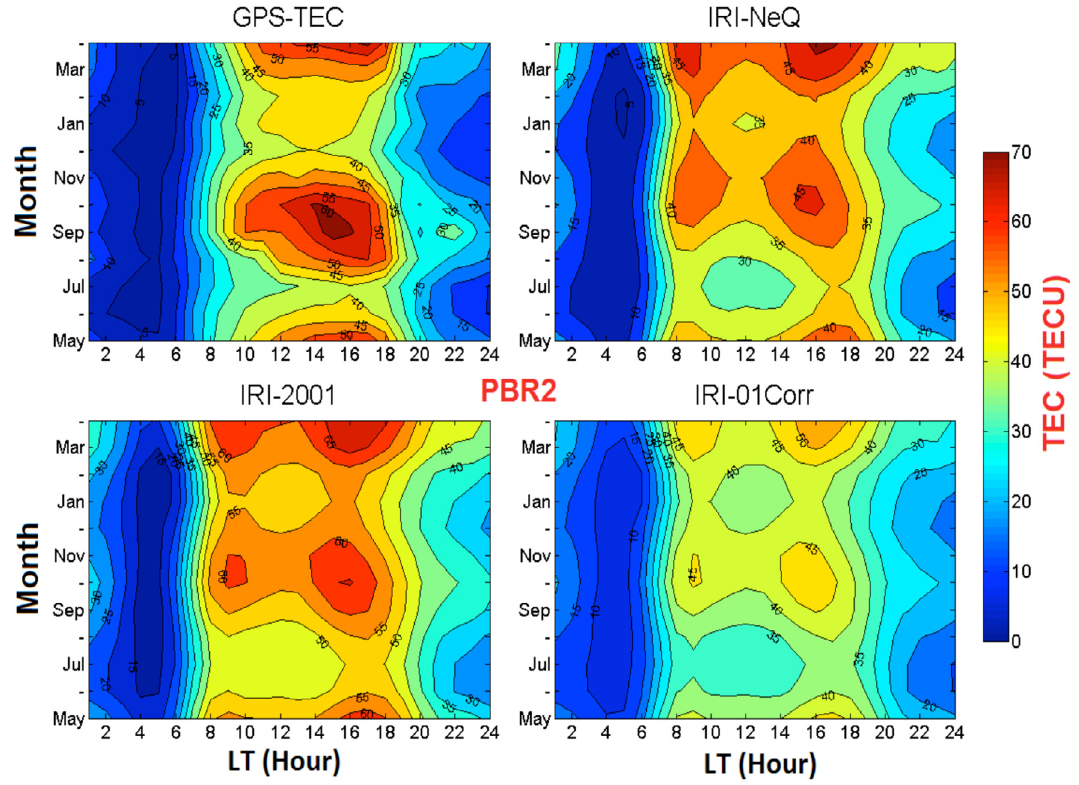
Figure 3. Contour diagram of monthly mean variation of GPS-TEC, IRI 2012 model TEC (NeQuick, IRI- 2001 and IRI-01-corr) at Port Blair (PBR2) (Geomagnetic lat. 2.11°N) from May 2012 to April